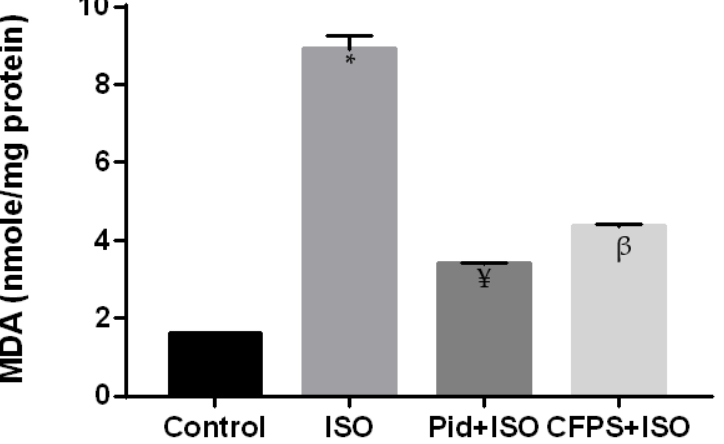
Figure 5. Effect of CFPS precotreatment on lipid peroxidation products in the heart tissues of the control and experimental groups of rats. Values are expressed as mean ± SD (n = 8). * p < 0.05: controls vs. ISO. ¥ p < 0.05: CFPS + ISO or Pid + ISO vs. ISO. β p < 0.05: CFPS + ISO vs. Pid + ISO.